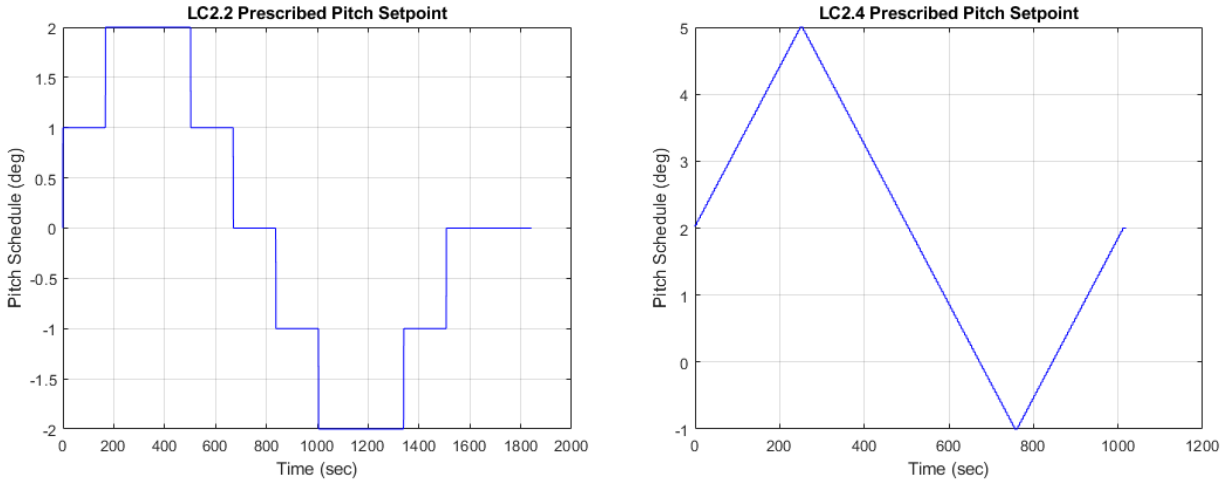
Figure 6. LC 2.2 ( left ) and LC 2.4 ( right ) pitch schedules.